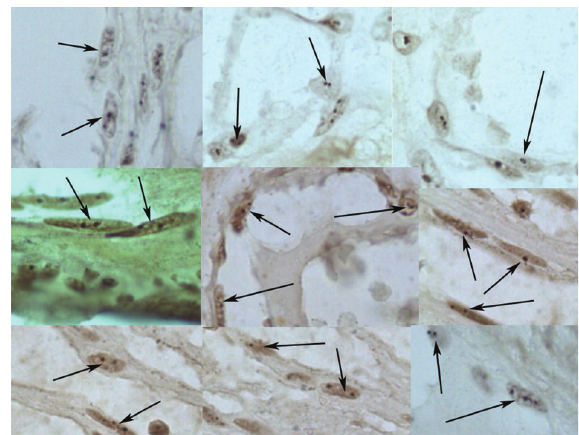
Figure 1: The number of AgNORs of vascular endothelial cells in native myometrium, as estimated using AgNO 3 . The number of argyrophilic granules in endotheliocyte nuclei from di ff erent areas of microvessels is not more than 2-3 granules per 2 ring- shaped nucleoli. The arrows are pointing at endothelial cells with argyrophilic